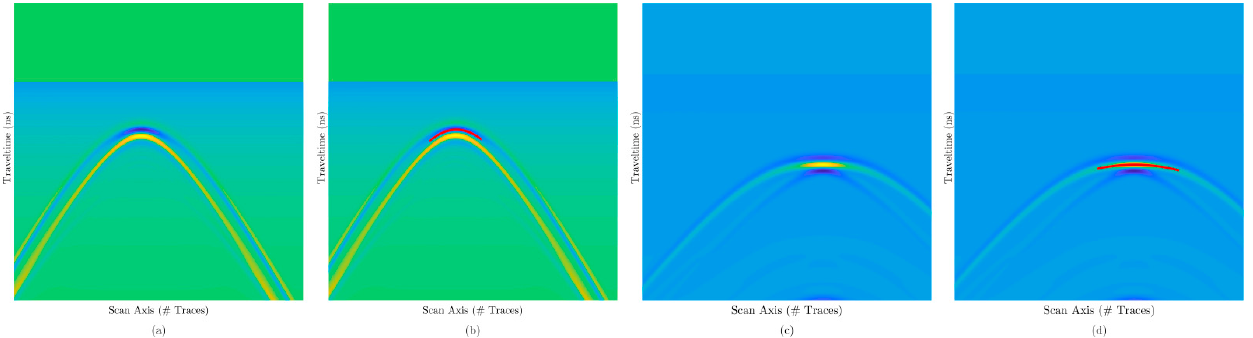
Figure 7. GPR B-SCAN image feature curve detection results. ( a ) Air-filled target; ( b ) fitted air-filled target feature curve; ( c ) water-filled target; ( d ) fitted water-filled target feature curve.